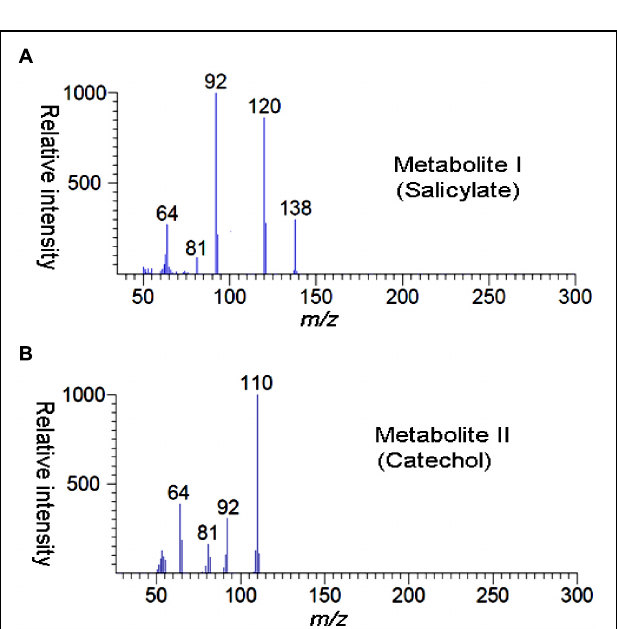
Frontiers in Microbiology |